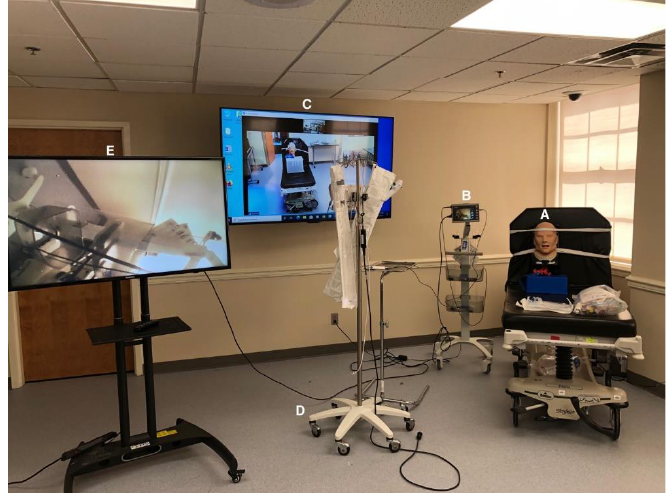
Figure 2 . Room for emergency medicine resident learner. Manikin head for nasopharyngoscopy and intubation (A); fiberoptic flexible bronchoscope (B) connected to monitor (E); Zoom projection of facilitator in nearby location (C); additional intubation scope for teaching and debriefing (D); and projected fiberoptic camera for ease of facilitator visualization